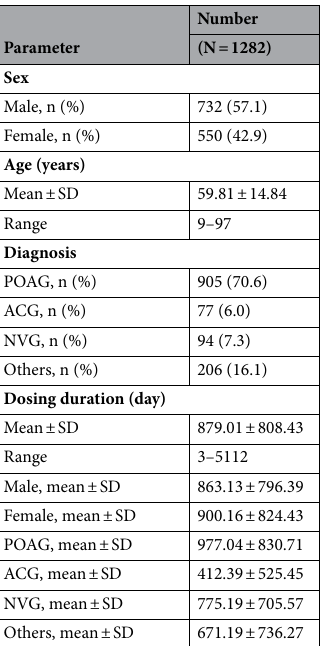
Table 1. Baseline demographics of total patients with topical dorzolamide-timolol. Values are presented as mean ± standard deviation unless otherwise indicated. POAG primary open-angle glaucoma, ACG angle- closure glaucoma, NVG Neovascular